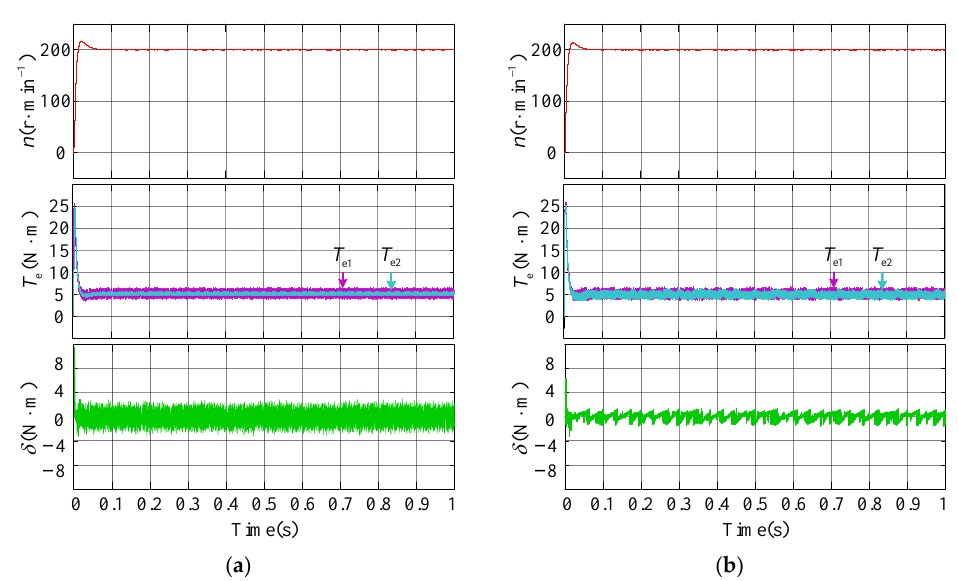
Figure 9. Simulation results with R s2 / R s1 = 1.3, L 2 / L 1 = 1.3: ( a ) the closed-loop control strategy and ( b ) the proposed FCS-MPC strategy.